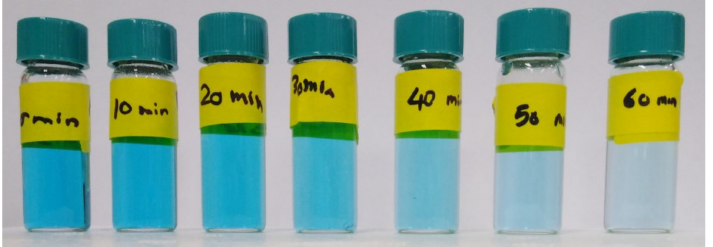
Figure 10. Change in MB solution color at 10 min intervals for 1 h due to photocatalytic decomposition under visible light